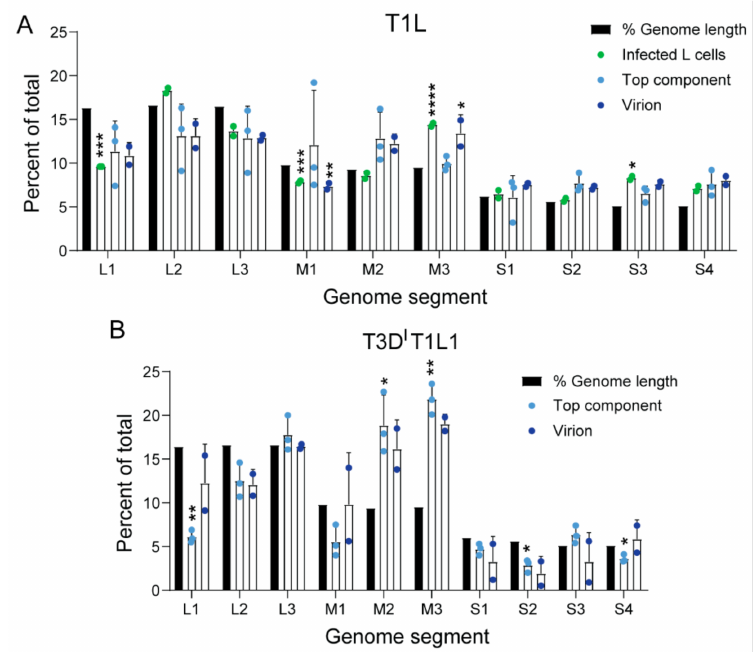
Figure 3. Percentage of packaged viral reads for each reovirus segment. The percentage of total T1L reference genome length was calculated for each genome segment and is indicated with a black bar. Numbers of viral reads from Illumina-ready libraries mapping to each segment were identified by alignment with the reference sequence. The percentage of total viral reads was calculated for each particle type. Shown are percentages calculated for TC (light blue), virions (dark blue), or infected L cells (green) for rsT1L ( A ) or rsT3D I T1L1 ( B ). Error bars represent standard deviation. n = 2 or 3 independent library preparations. *, p < 0.05; **, p < 0.01; ***, p < 0.001; ****, p < 0.0001 compared with percentage of total T1L reference genome length by one-sample t